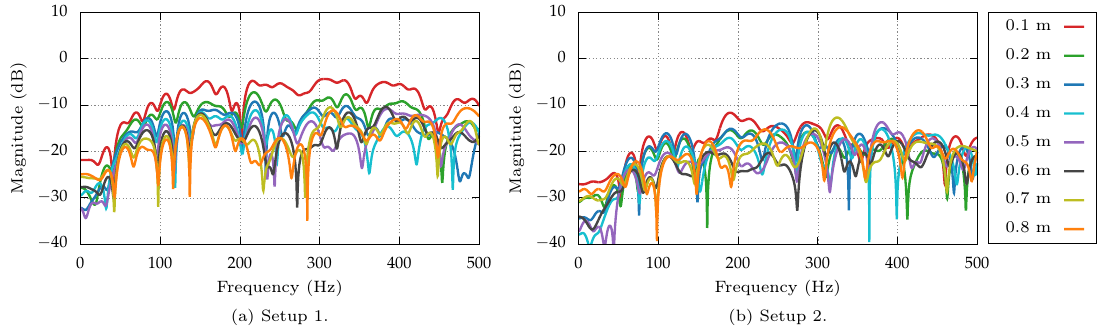
Figure 9. The amplitude functions of the frequency functions of the impulse response estimates for the secondary paths between back casing panel’s selected actuator and the error microphone adjacent to the back casing panel, at all distances, in both setups.